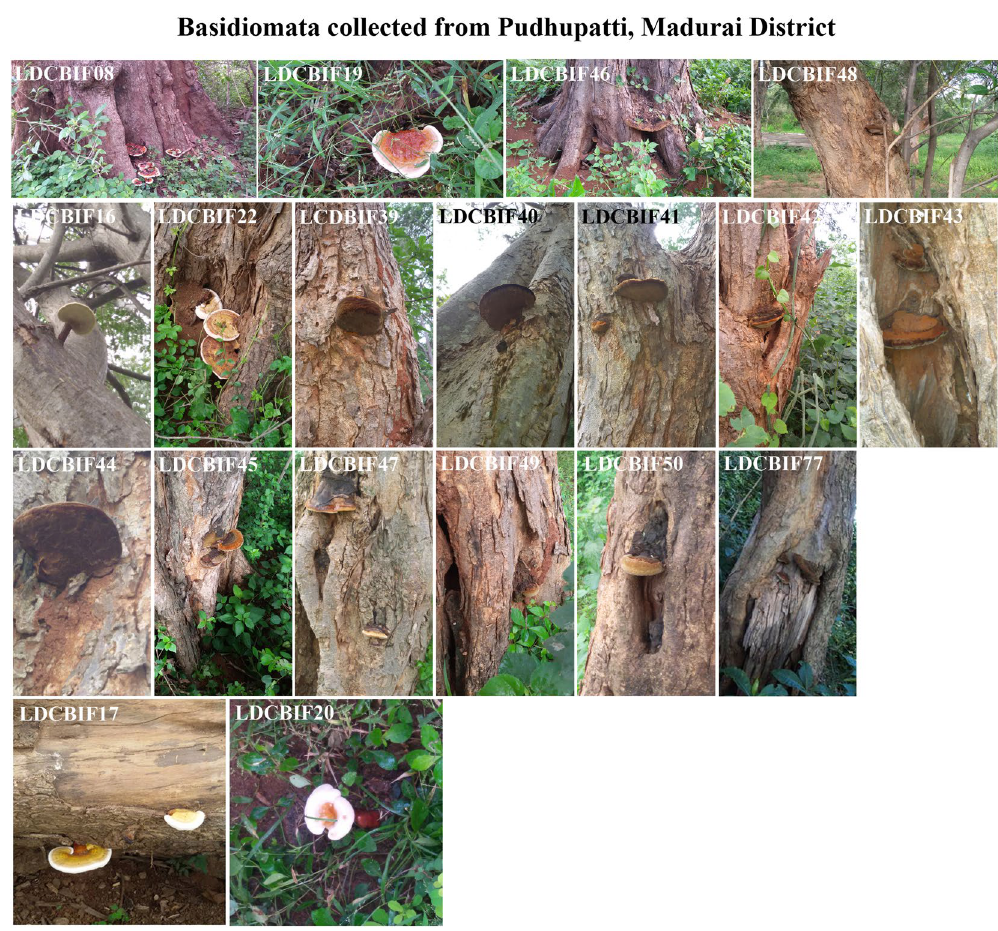
Figure 3. Field photographs of Basidiomata collected from Pudhupatti, Madurai District. The macrofungi grown on the host species: Albizzia sp., - LDCBIF16 - LDCBIF22, LDCBIF39, LDCBIF40 - LDCBIF50 and LDCBIF77; Tamarindus sp., -